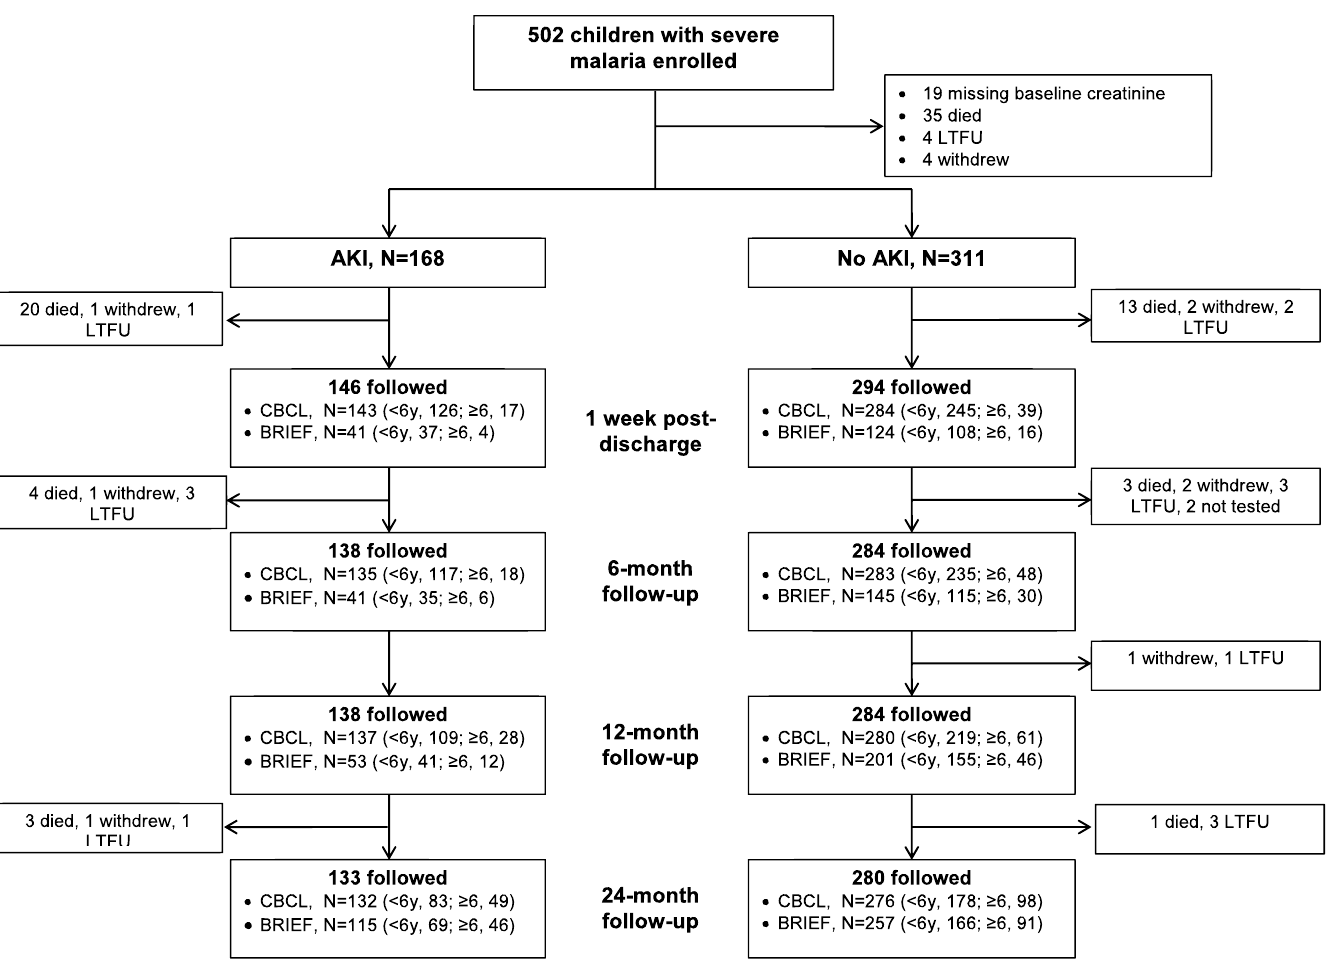
Fig 1. Flow chart of the study population. Abbreviations, acute kidney injury (AKI), lost-to-follow-up (LTFU), child behavior checklist (CBCL), Behavior Rating Inventory of Executive Function (BRIEF).